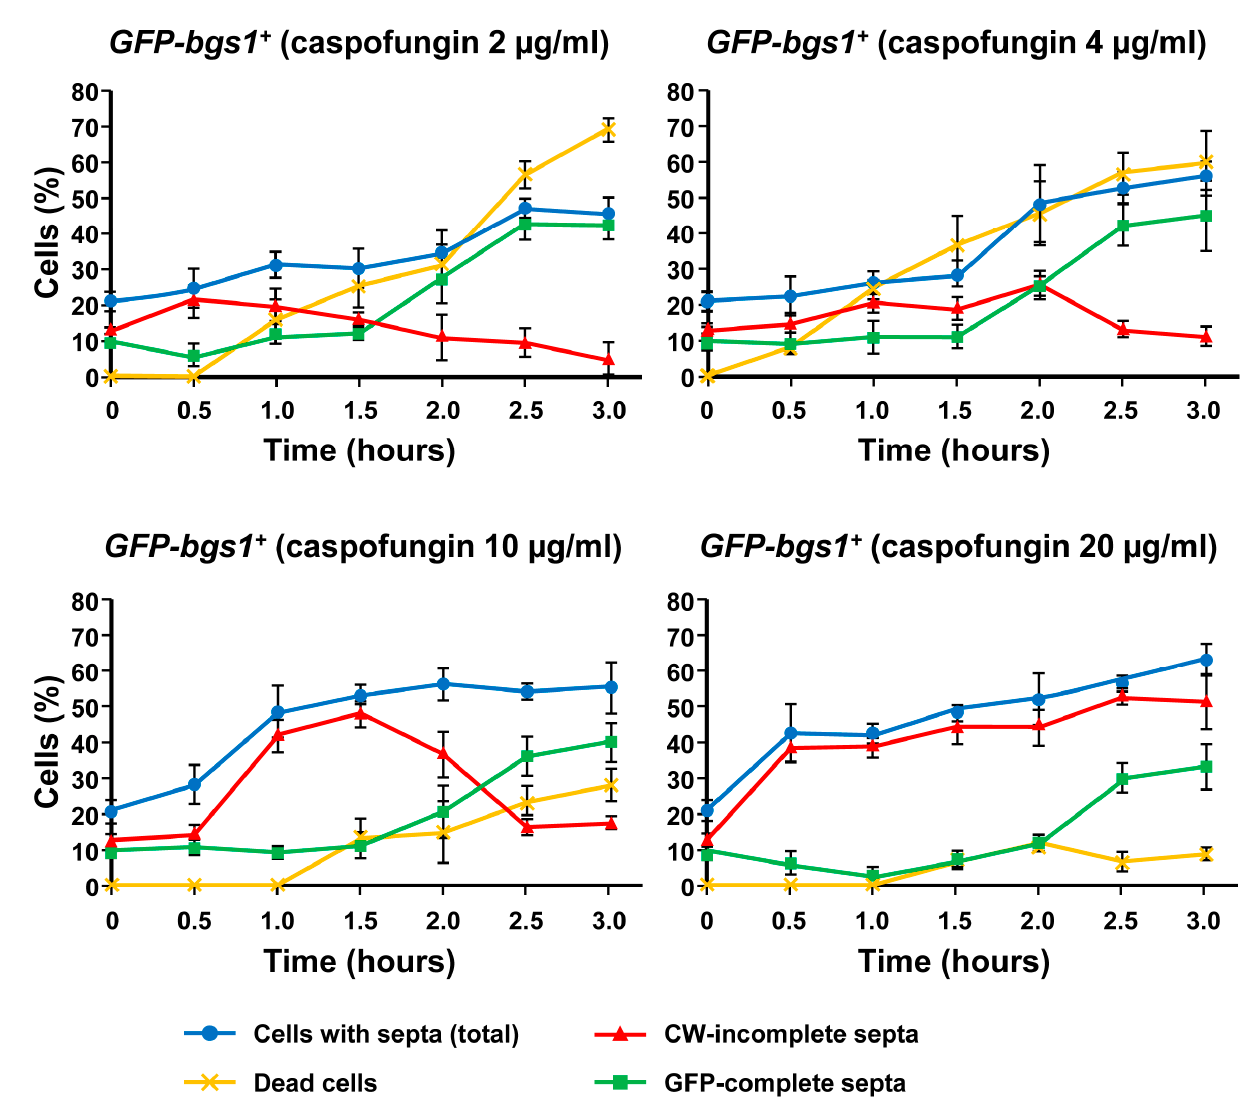
Figure 6. Percentages of the total GFP ‐ bgs1 + dead cells (yellow line), CW ‐ stained total septa (blue line), CW ‐ incomplete septa (red line), and GFP ‐ complete septa (green line) either in the absence (time 0 h) or in the presence of sublethal (2 and 4 μ g/mL) and lethal (10 and 20 μ g/mL) concentrations of caspofungin. Cells were grown and imaged at the indicated times and drug concentrations as in Figure 2. Error bars indicate standard deviation.